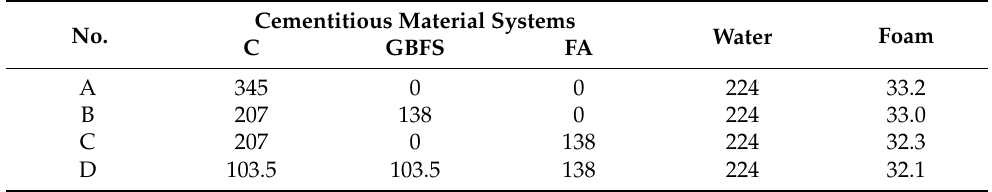
Table 4. Compounding ratios for FLS (kg/m 3 ).